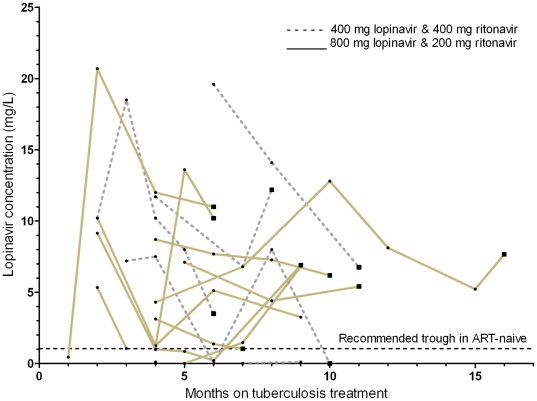
Lopinavir concentrations of individual patients during the study period.The circles indicate lopinavir concentrations measured while patients were receiving tuberculosis treatment, while the squares indicate lopinavir concentrations once tuberculosis treatment has been completed.